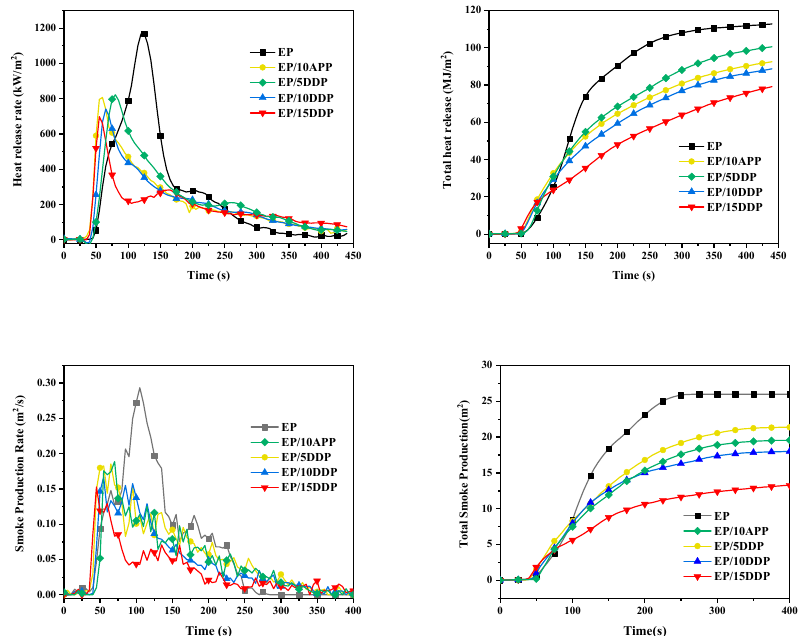
Table 3. Cone calorimeter data of the flame ‐ retarded EP blends at a heat flux of 50 kw/m 2 . Samples